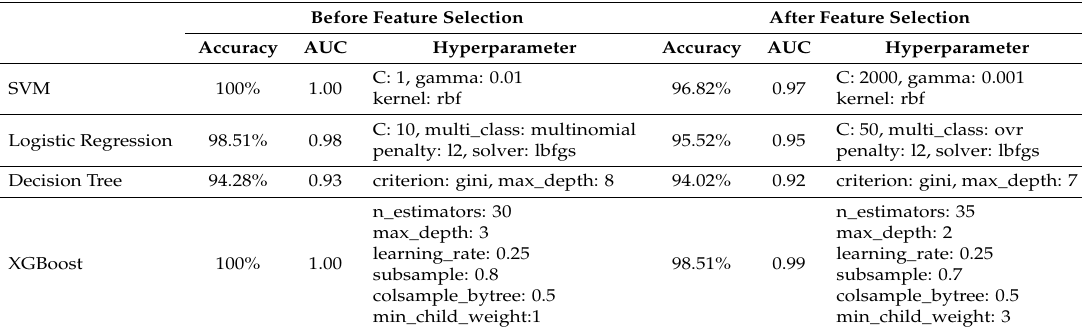
Table 5. Classification performance and the optimal hyperpapameters of the proposed